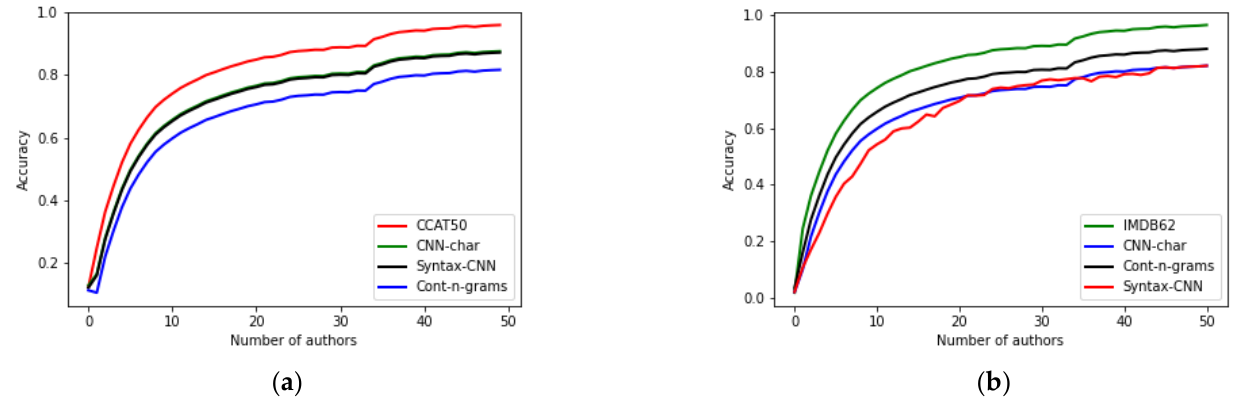
Figure 6. Performance accuracies on ( a ) CCAT50 dataset, and ( b ) IMDB62 dataset compared to SOTA